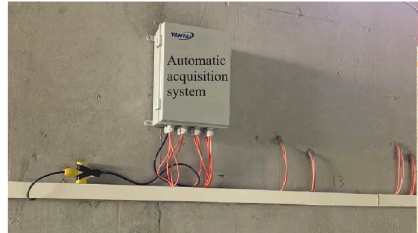
Figure 6: Schematic diagram of the automated acquisition system.